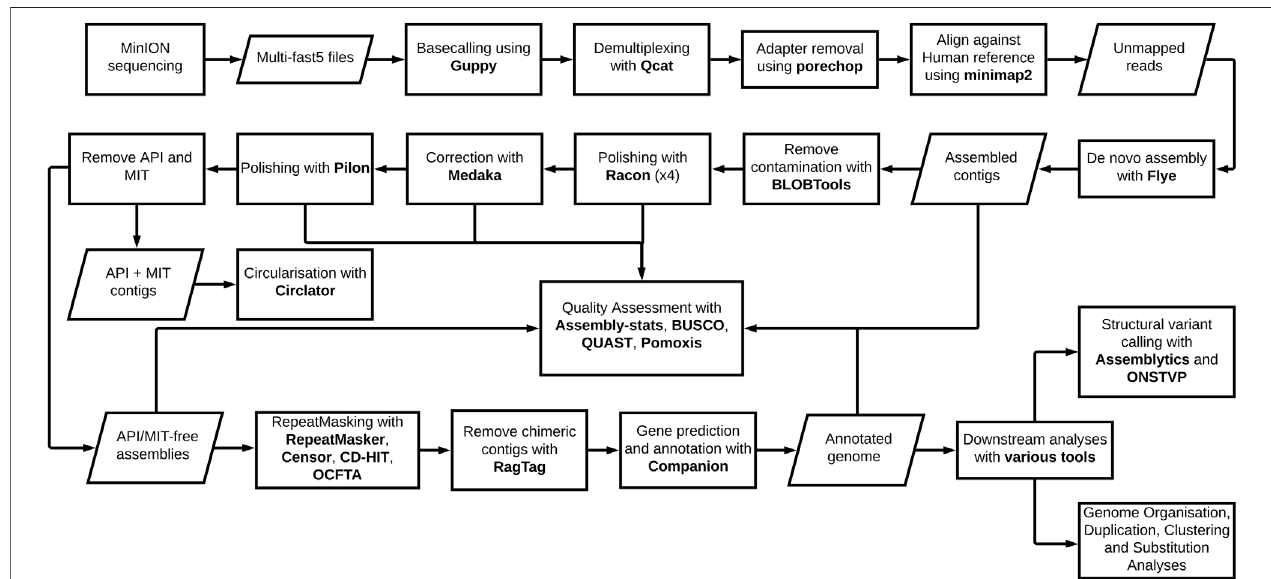
FIGURE 1 | Plasmodium knowlesi de novo genome pipeline. The pipeline represents major forms of manipulation taken and tools utilized to generate, annotate, and analyze the two reference genomes derived from clinical isolates and the experimental